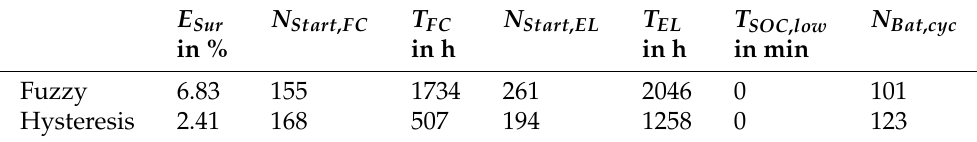
Table 3. Comparison between expert tuned controller and three-point hysteresis controller.